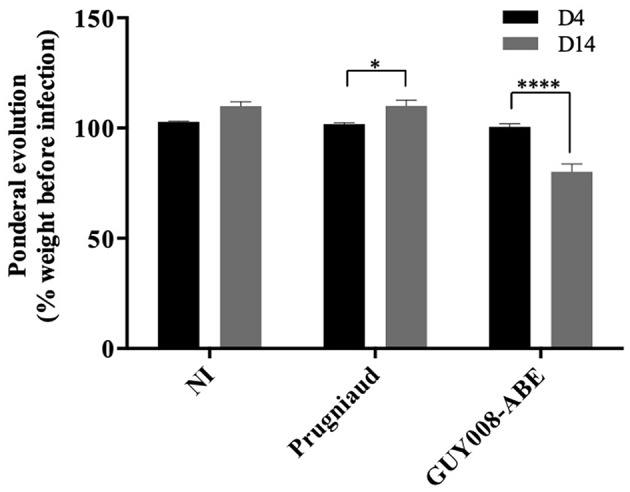
Ponderal evolution of F344 rats after Toxoplasma gondii infection. Rats were intraperitoneally infected with 107 tachyzoites of type II Prugniaud (n = 8) or GUY008-ABE (n = 8) strains. Un-infected (NI) rats were used as controls (n = 5). Animals were weighted at days 4 and 14 post-infection. Percentages of weight regarding animal weight before infection were calculated and means ± SEM represented. Values were submitted to 2way ANOVA analysis followed by a Tukey's multiple comparisons test (*p < 0.05, ****p < 0.0005).